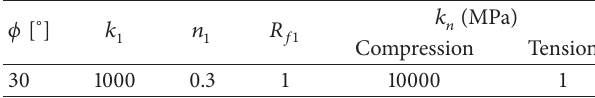
Table 4: Parameters of the Goodman interface model. Table 5: Comparison of the maximum